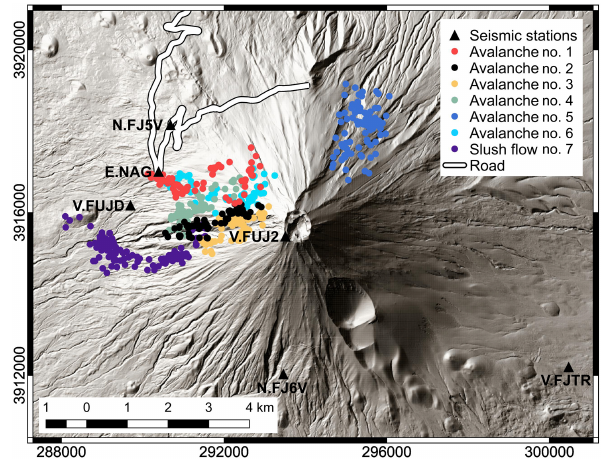
Figure 7. Map showing the seismic locations of the seven detected events as estimated by ASL (Table 1). Each flow is represented by a different color.